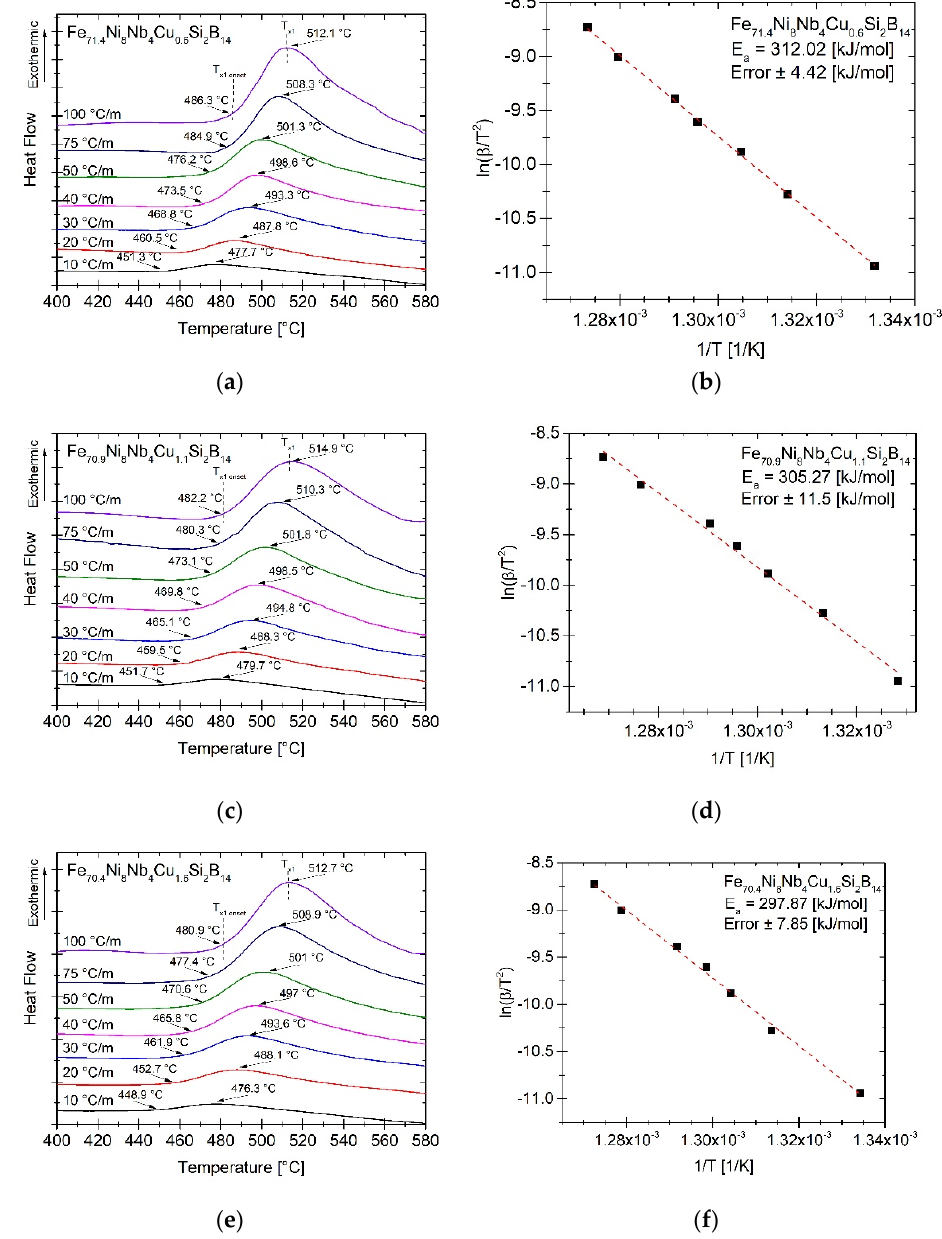
Figure 3. The DSC thermograms for heating rates ( a , c , e ) ranged from 10 to 100 ◦ C/min and Kissinger plots determined for crystallization peak temperatures T x1 ( b , d , f ) of as-spun amorphous